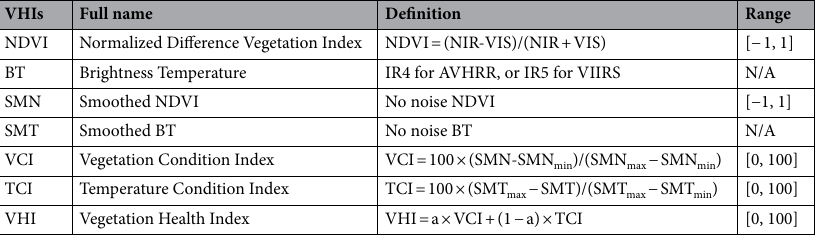
Table 1. Definition of